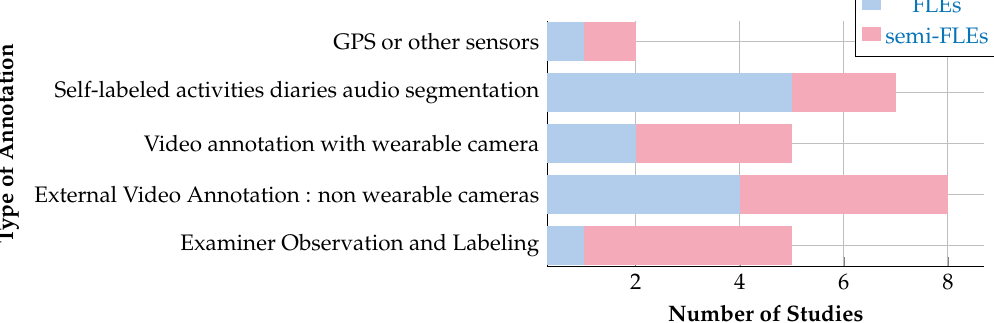
Figure 14. Distribution of the different kind of activities/physical behaviors/stationary phases annotations depending on